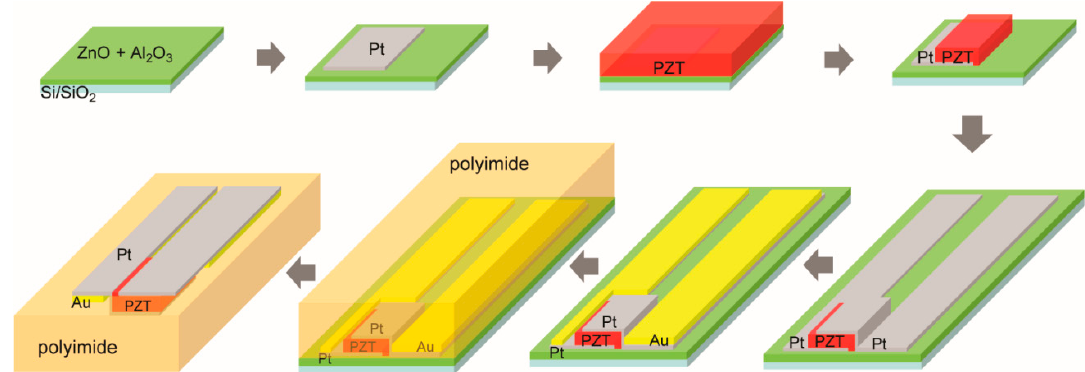
Figure 1. Process for fabricating flexible thin-film PZT bar resonator-type transducers on a few micron thick polyimide